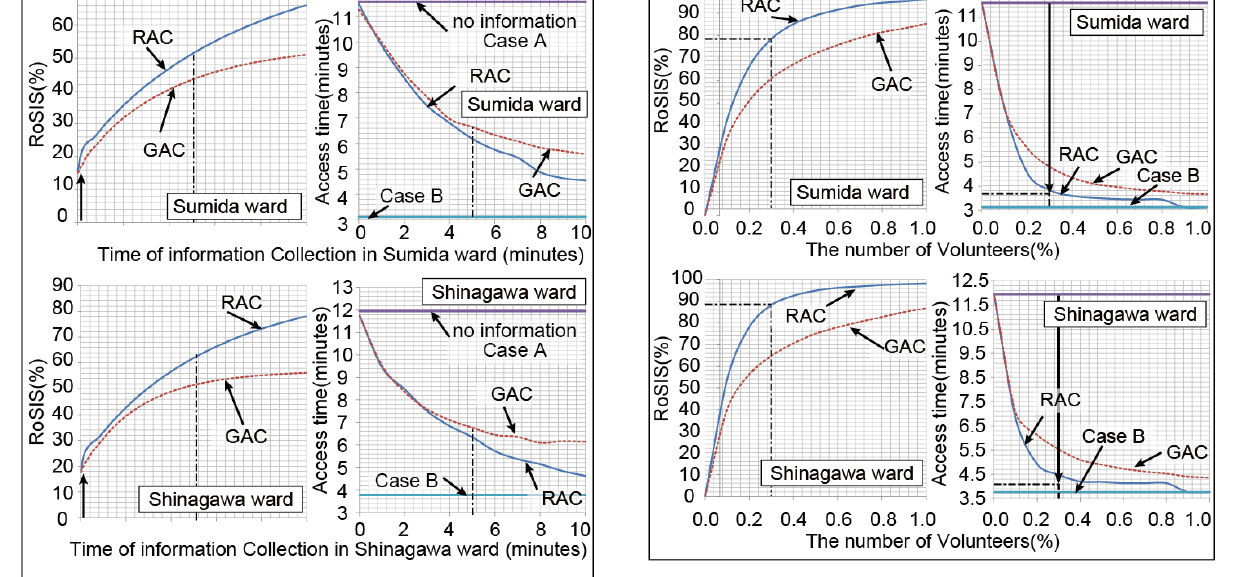
Figure 12. Difference between the two strategies